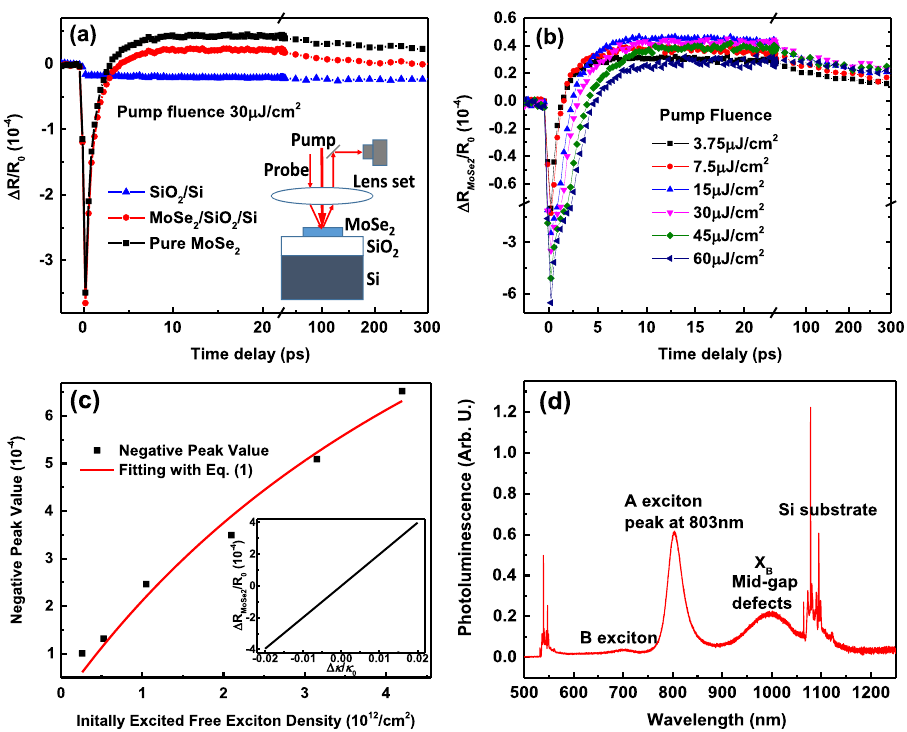
Fig. 1 a Differential re fl ection signals, Δ R / R 0 , measured at pump fl uence of 30 μ J/cm 2 , for both SiO 2 /Si and MoSe 2 /SiO 2 /Si structures. The black squares represent the extracted signal of pure MoSe 2 . Inset : sample structure and pump-probe detection geometry. b The extracted signals of pure monolayer MoSe 2 at various pump fl uences. c Absolute values of the negative peak of signals in Fig. 1b and the fi tting with the saturable absorption model (Eq. 1). Inset : Simulation of Δ R MoSe CVD monolayer